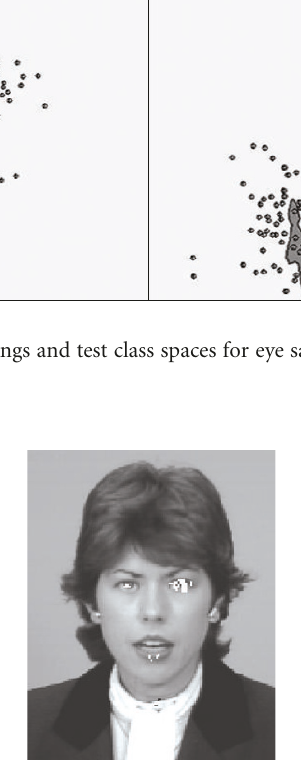
Figure 7: Image from visual telephone image sequence “Claire” with detected eye regions marked in black or